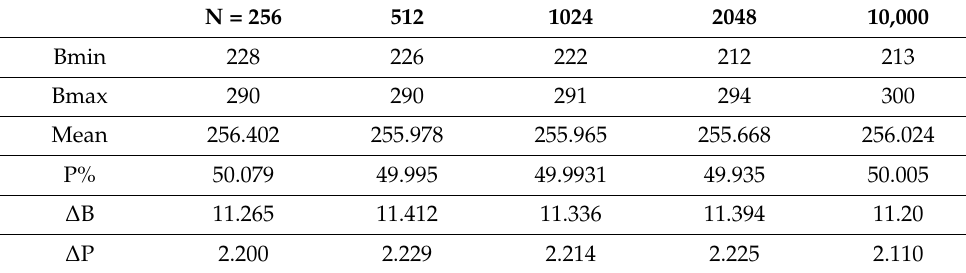
Table 11. Statically results for structure 3 for a number of different tests.